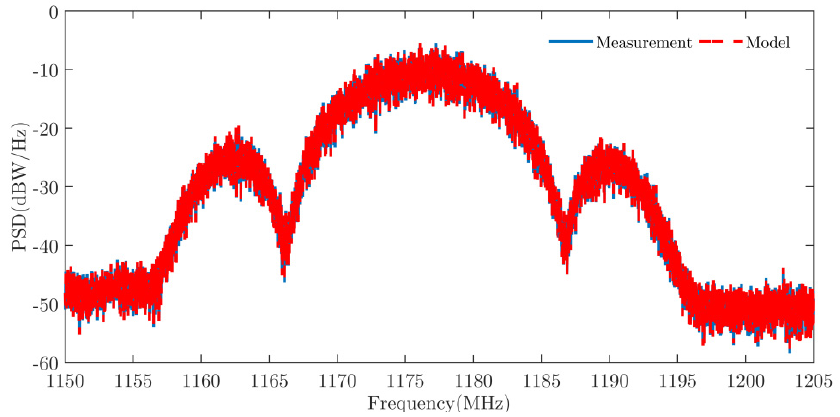
Figure 7. BIII-2 L5 PSD.